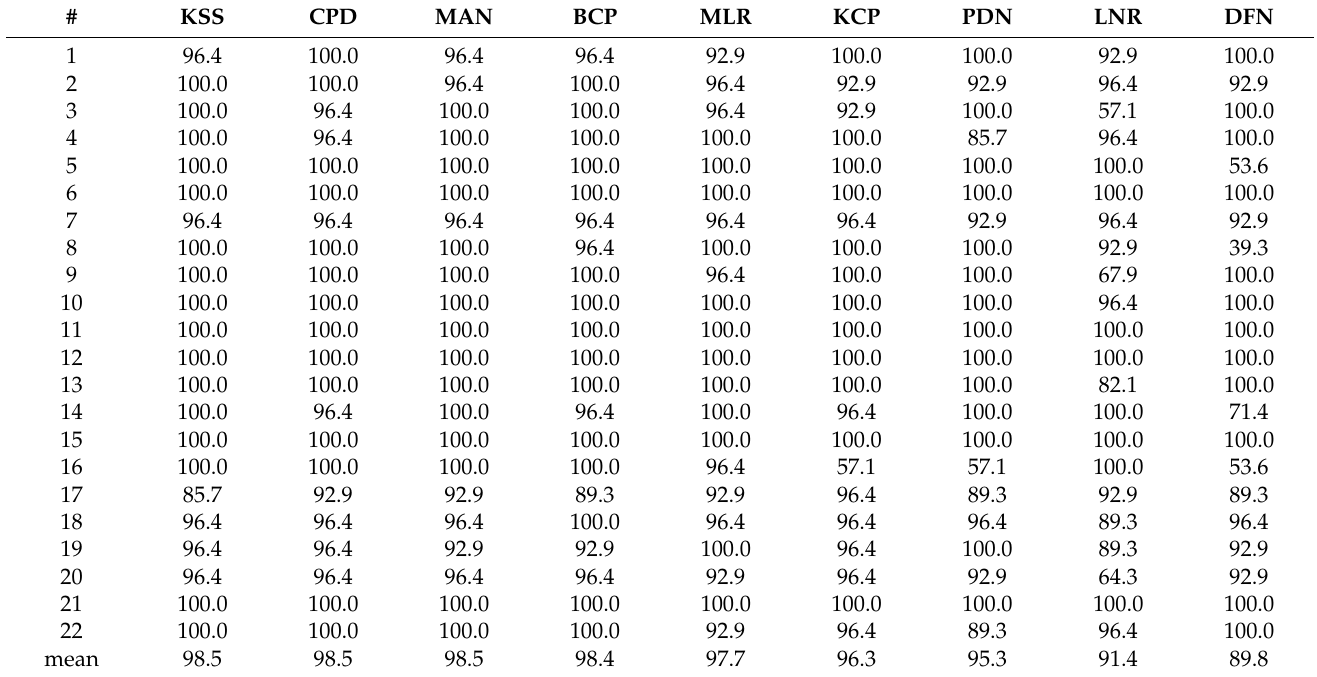
Table 4. Maximum PC values of all algorithms for each event for arbitrary optimal [ T 1, T 2 ]